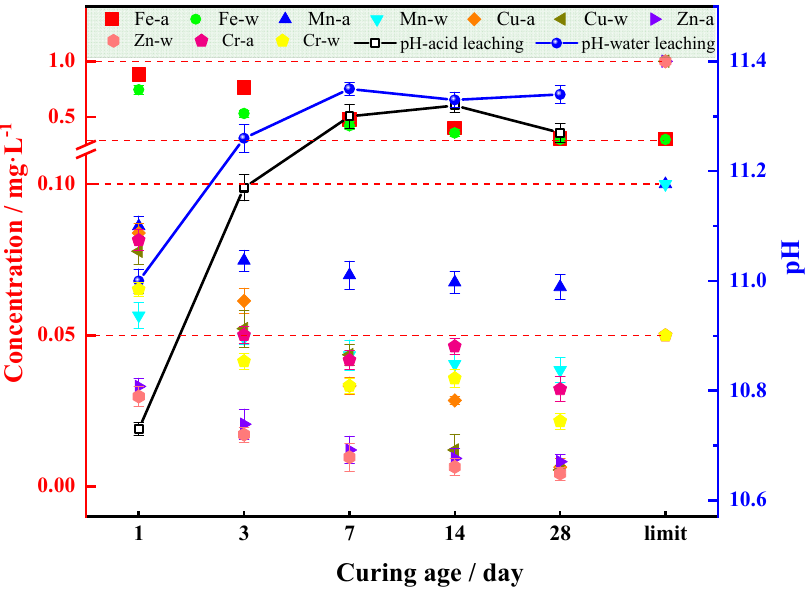
Figure 13. Variation in the COSGB contaminant leaching concentration at different curing ages. The red line in Figure 13 indicates the standard concentration limit of each heavy metal ion according to the Chinese groundwater quality standard. As seen in Figure 13, the leaching levels of the COSGB are lower than the levels defined in the Chinese groundwater quality standard in the water (-w in Figure 13) and acid leaching (-a in Figure 13) states except Fe 2+ , which slightly exceeds the standard. Fe 2+ content of the original backfill materials, the SS and OSR, are high, which results in the slight overrun of Fe 2+